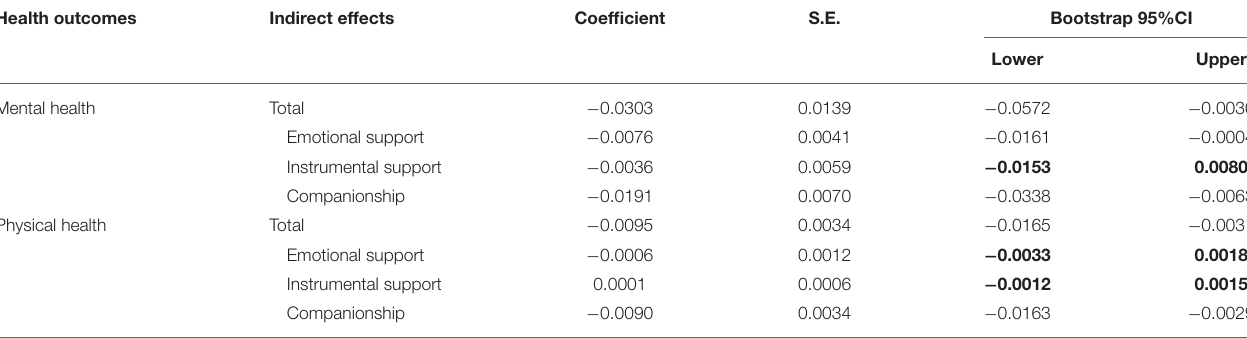
TABLE 2 | Mediation effects of the subtypes of social support in the association between widowhood and health status in the whole sample ( N = 7,647). Health outcomes